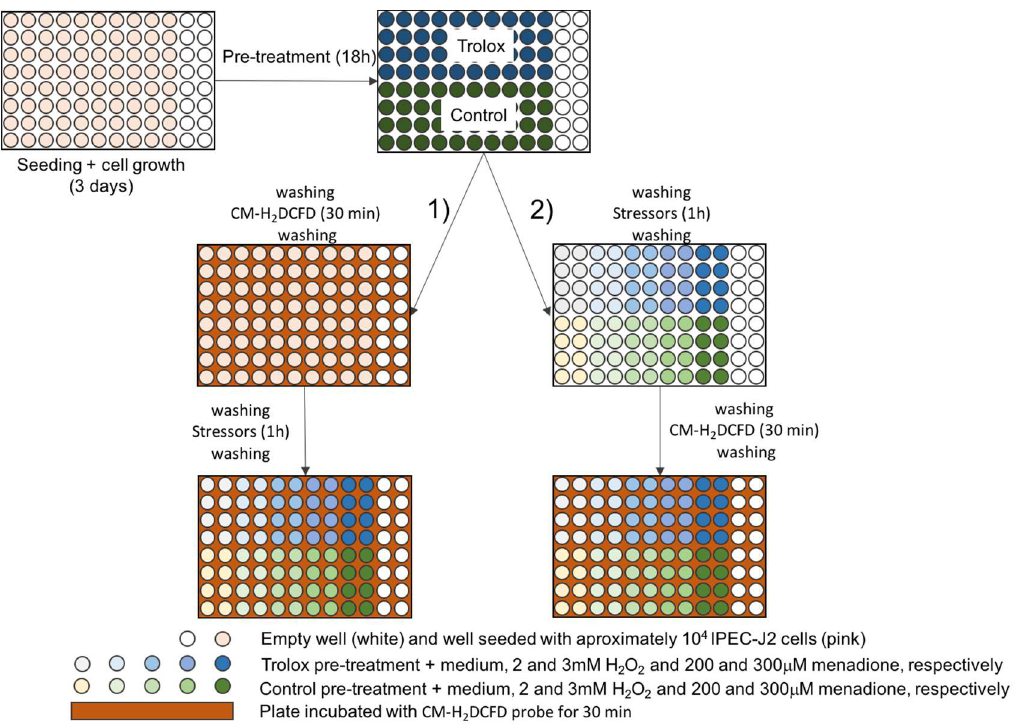
Figure 7. Plate layout during optimization of the in vitro oxidative stress assay. (1) and (2) are different protocols tested during the optimization process in order to obtain the best signal-to-noise ratio.